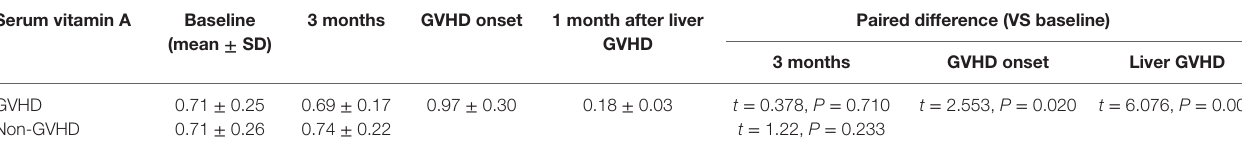
Table 4 | compare the score of dry eye symptoms between graft-versus-host disease (gVhD) and non-gVhD patients. serum vitamin a